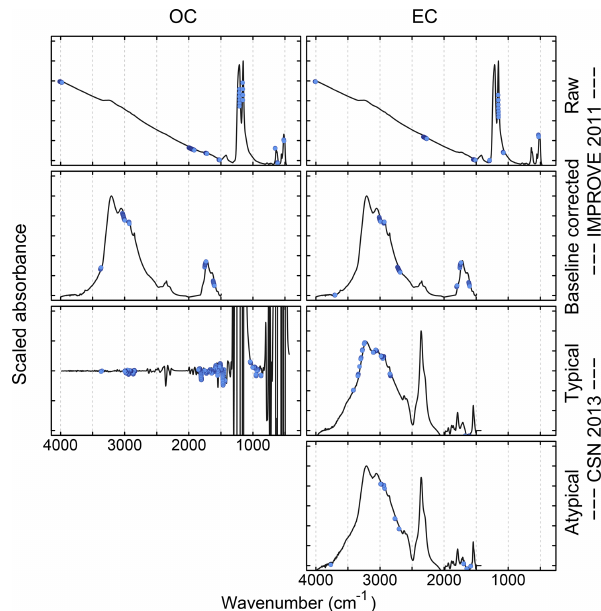
Figure 8. Selected wavenumbers (blue points) overlayed on mean of calibration spectra (black lines). The 2011 IMPROVE spectra remain unprocessed (“raw”) or baseline corrected using smooth- ing splines (“baseline corrected”), while the 2013 CSN spectra are baseline corrected using the Savitzky–Golay second-derivative ap- proach. “Atypical” and “typical” categories for 2013 CSN EC refer to samples for Elizabeth, NJ, and the remaining nine sites, respec-